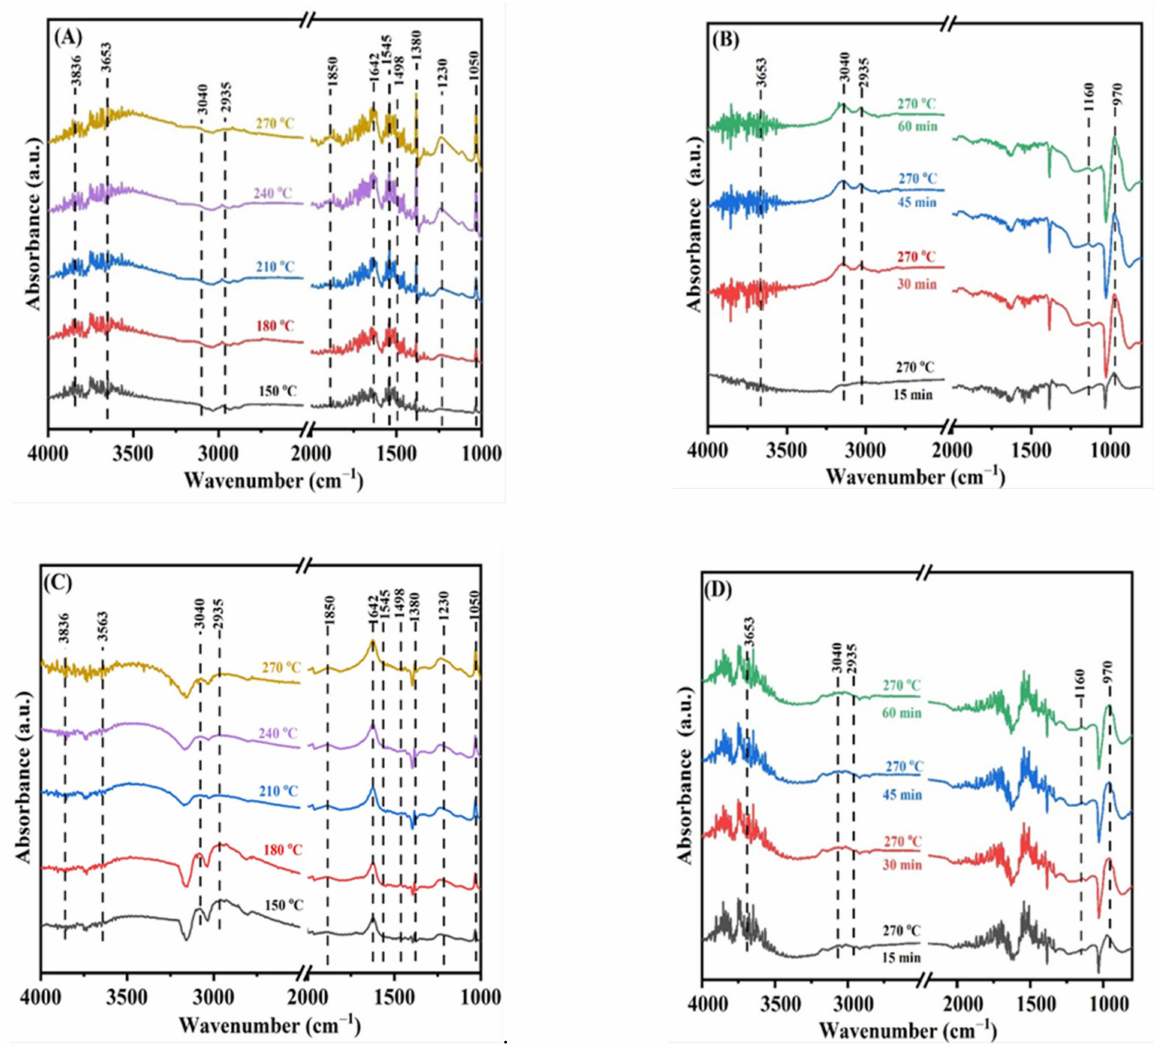
Figure 9. In situ DRIFTS spectra of ( A , B ) 0.47Pt/V 2 O 5 -TiO 2 and ( C , D ) 0.46PdPt 2.10 /V 2 O 5 -TiO 2 for ( A , C ) C 7 H 8 at different temperatures and ( B , D ) (C 7 H 8 + SO 2 ) oxidation at different times (after activation treatment in an O 2 flow at 250 ◦